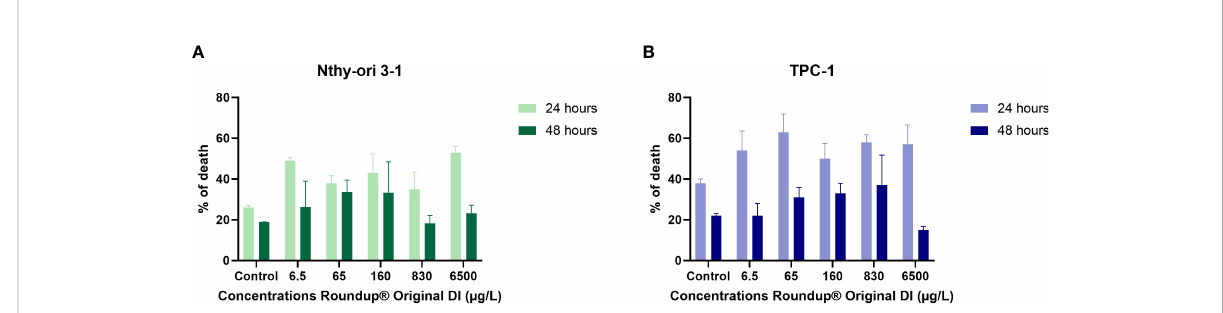
FIGURE 2 Comparison of cell mortality in Nthy-ori 3-1 (A) and TPC-1 (B) strains after exposure 216 to increasing concentrations of Roundup® Original DI for 24 h and 48 h by Trypan blue dye